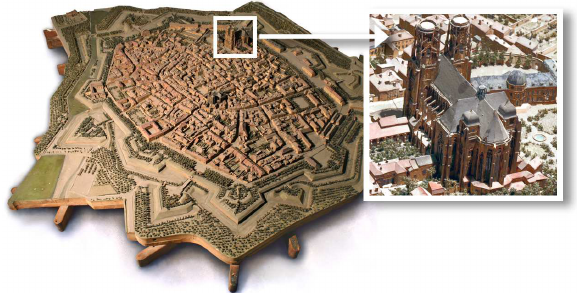
Figure 1. The main table of the plan-relief of Toul (2.23m x 2.13m) and a detail showing the ten centimetres height